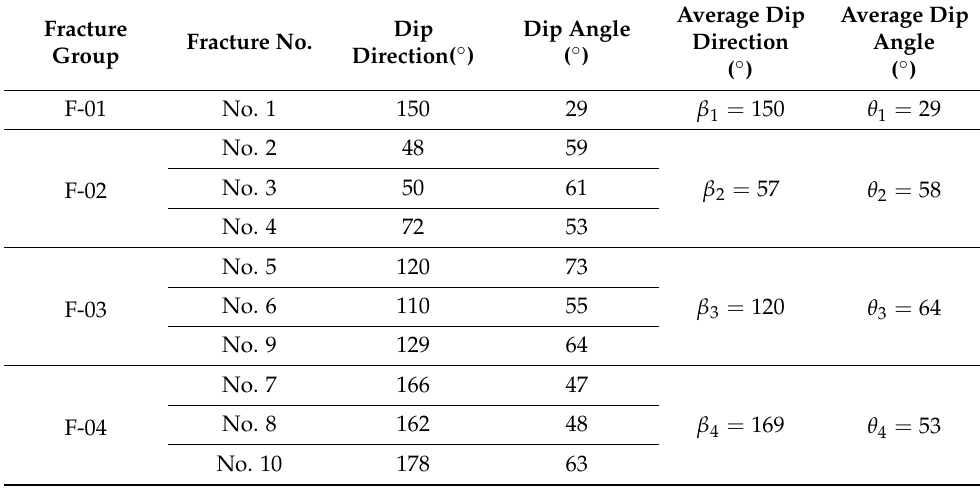
Table 6. Fracture classification